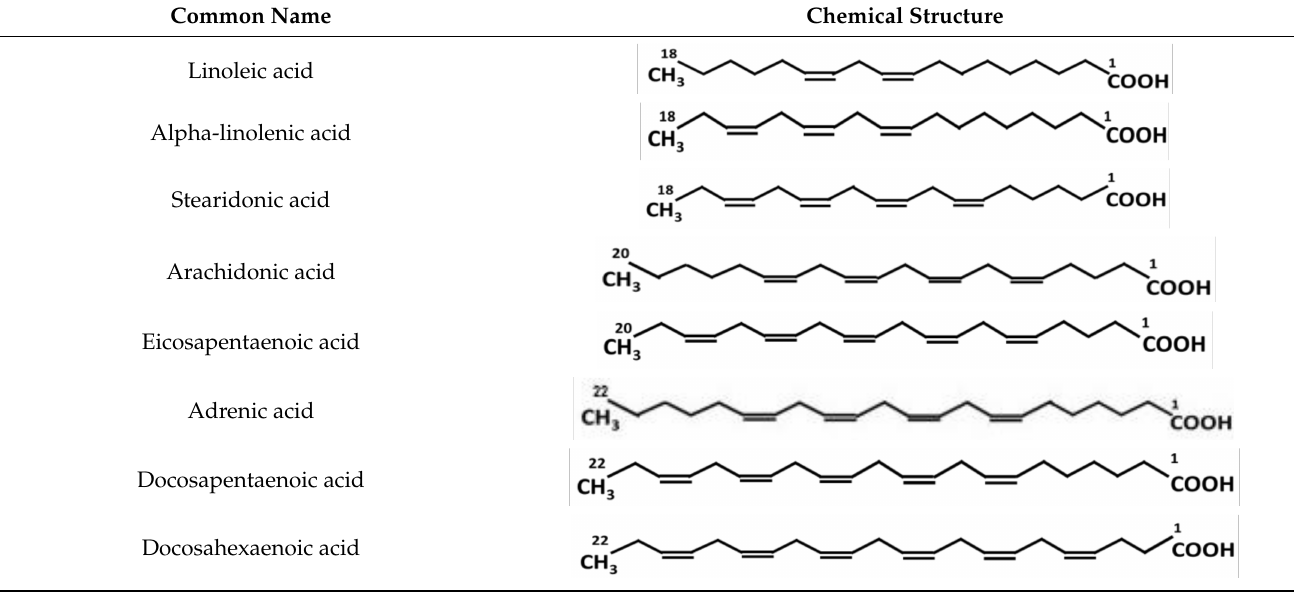
Table 2. Names and chemical structures of commonly available omega-3 and omega-6 fatty acids. Common